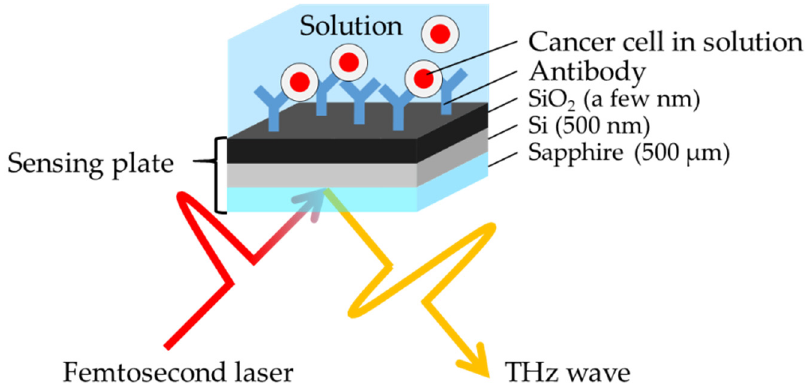
Figure 1. Schematic diagram of the sensing plate and the terahertz wave radiated from the sensing